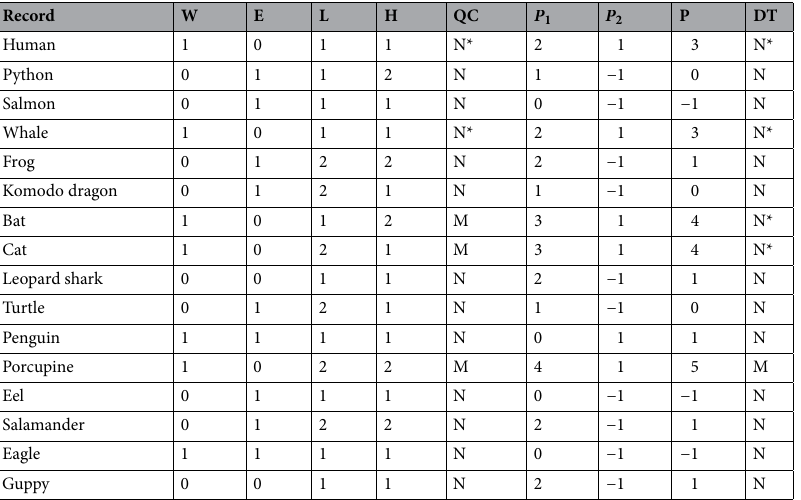
Table 3. The results of classification of vertebrates with two quantum classifiers (QCs) and decision tree algorithm as a classical one. The results of the first quantum classifier are presented in 6th column. Here, P 1 > 2 and P 2 1 identify mammal vertebrates. The mammals (M) and non-mammal (N) vertebrates can be = classified via the second classifier based on the values of P as shown in 9th column where mammal creatures 3 . The first classifier presents two misclassified records, while the second one correctly classifies all possess P ≥ of them. The results of decision tree (DT) algorithm are presented in th last column. The misclassified records are marked with asterisk symbol